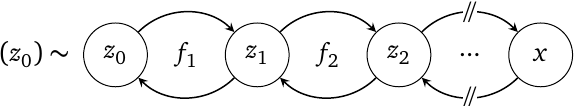
= x . In the inverse direction, starting n